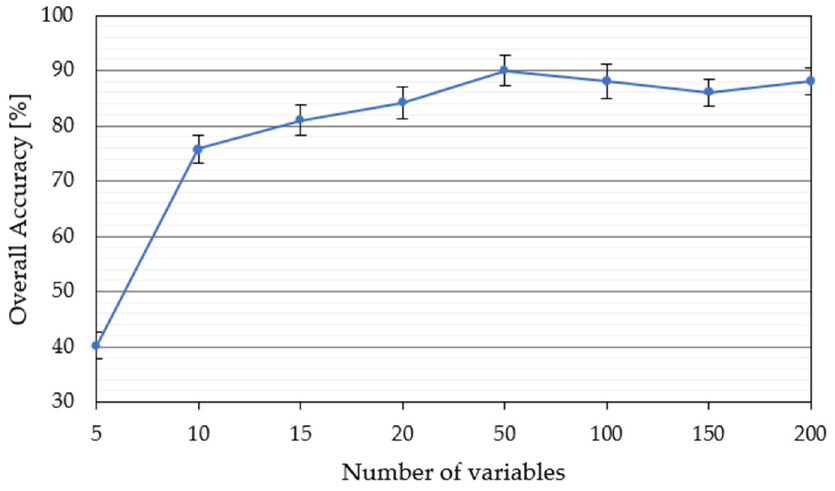
Figure 4. Mean overall accuracy (OA) for combined S1 and S2 time-series as a function of the various number of input features.